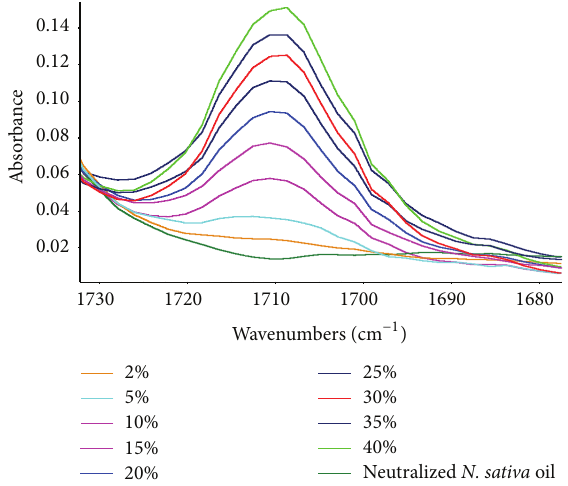
Figure 2: Group spectra of calibration standards spiked with oleic acid.